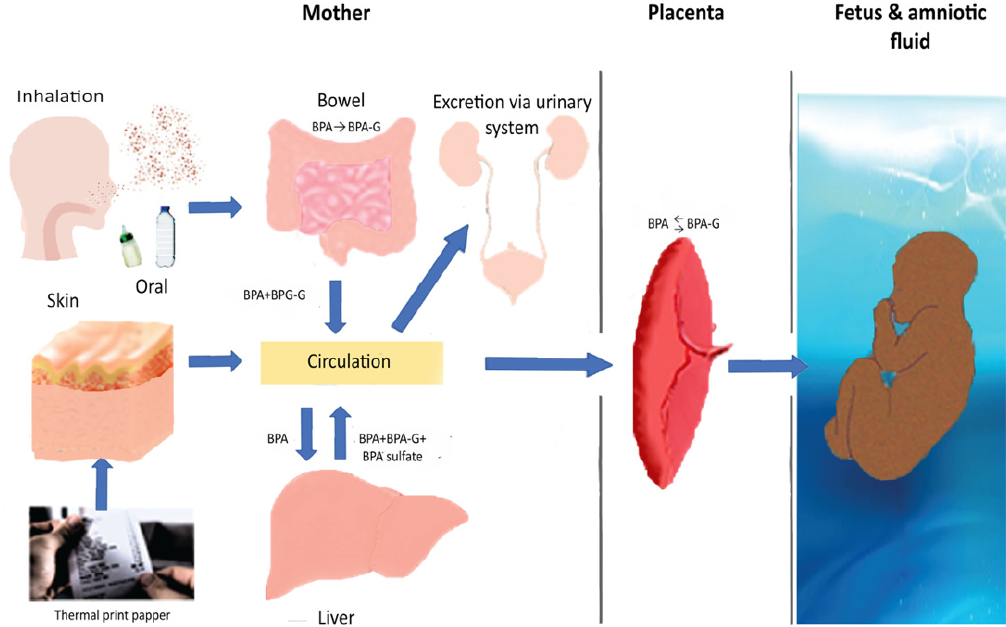
Figure 1. Bisphenol A metabolism. In adults, bisphenol A is mainly metabolized to BPA-glucuronide (BPA-G) in the liver, and a smaller proportion in the intestines, via UDP-glucuronyltransferase. Hepatic sulfation is another pathway (BPA sulfate via sulfotransferase). The metabolites are excreted in urine. They are inactive, but they can be deconjugated and return to the active form via β -glucuronidase (GUSB) and steroid sulfatase (STS). Skin contact seems to lead to longer exposure to free BPA. During pregnancy, BPA can pass through the placenta. The fetus is theoretically more vulnerable because of absent or reduced UDP-glucuronyltransferase, especially during the first two trimesters. It has also been proposed that it is capable of deconjugation, and the placenta can contribute to this procedure, thereby increasing the active form. Bisphenol A concentrations are the same (a) in the blood vessels in the placenta that carry fetal blood, (b) in the umbilical cord, and (c) in the blood circulation in the fetus.